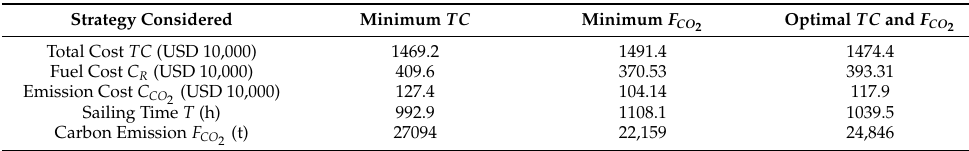
Table 10. A comparison of various emission control